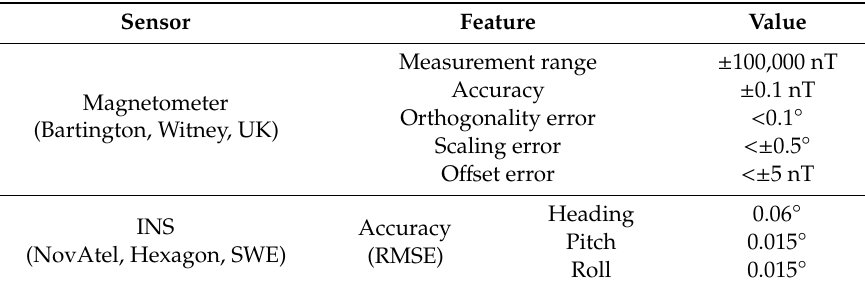
Table 3. The performance specifications of INS and magnetometer.